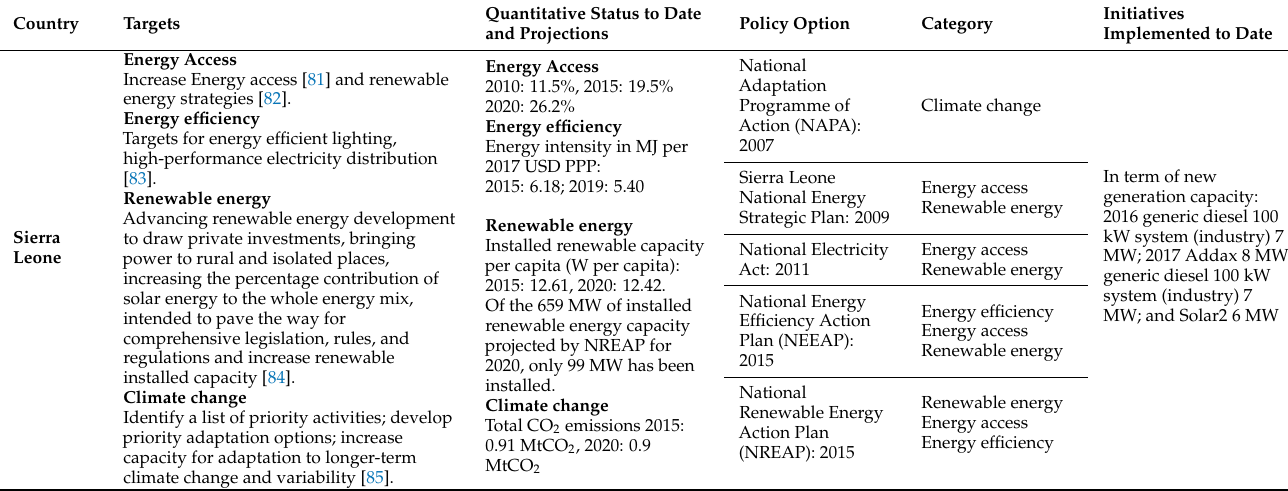
Table 14. Sierra Leone (data from